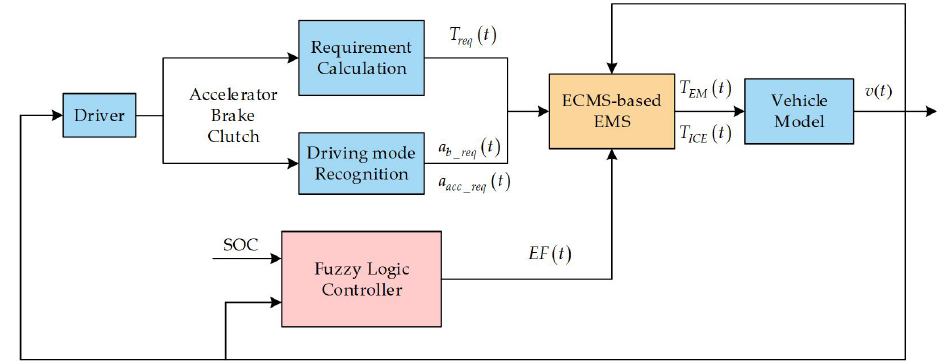
Figure 10. Flowchart of an ECMS-based EMS combined with fuzzy